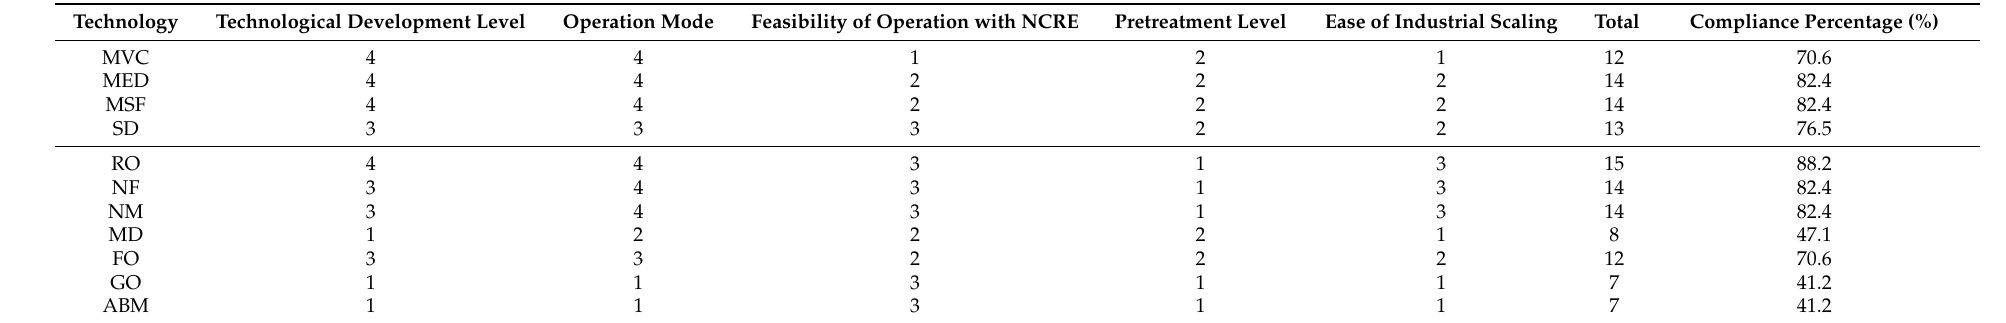
Table 6. Results of the comparative evaluation of desalination technology